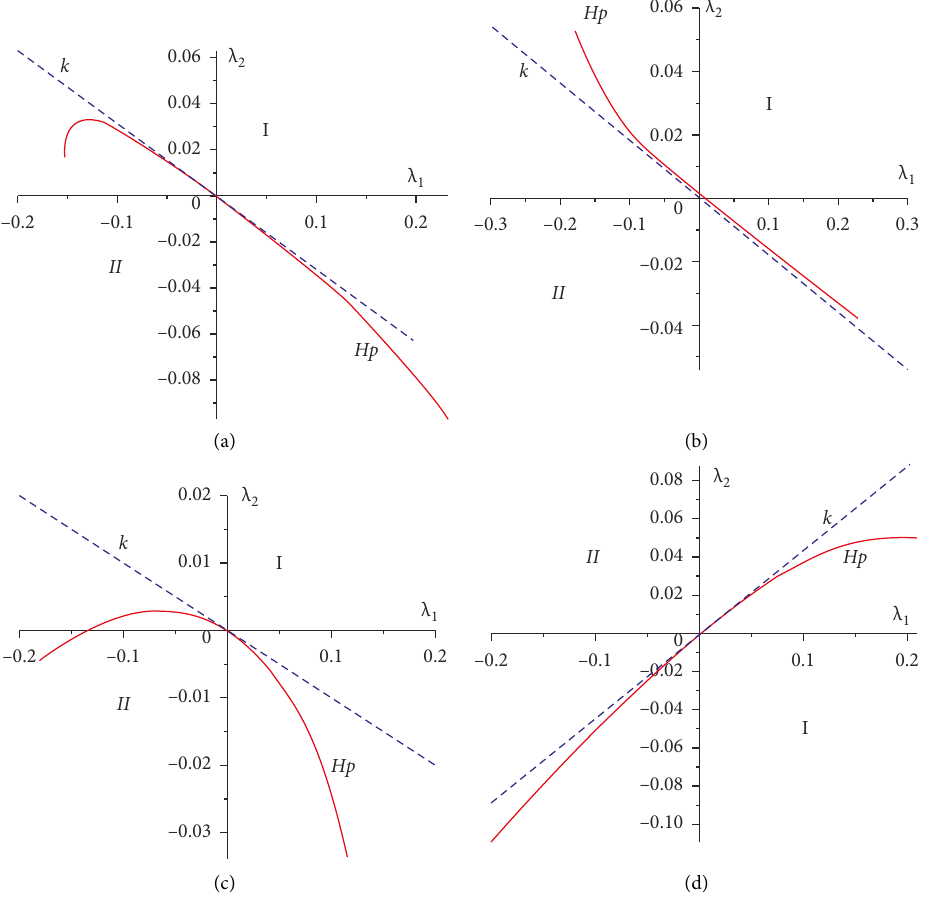
Figure 8: (a) Hopf bifurcation curve with λ � ( 1/2 ) and μ � 3 for the case ( C 2); (b) Hopf bifurcation curve with λ � ( 1/2 ) and μ � 10 for the case ( C 2); (c) Hopf bifurcation curve with λ � ( 1/3 ) and μ � 3 for the case ( C 3);(d) Hopf bifurcation curve with λ � ( 1/3 ) and μ � 10 for the case ( C